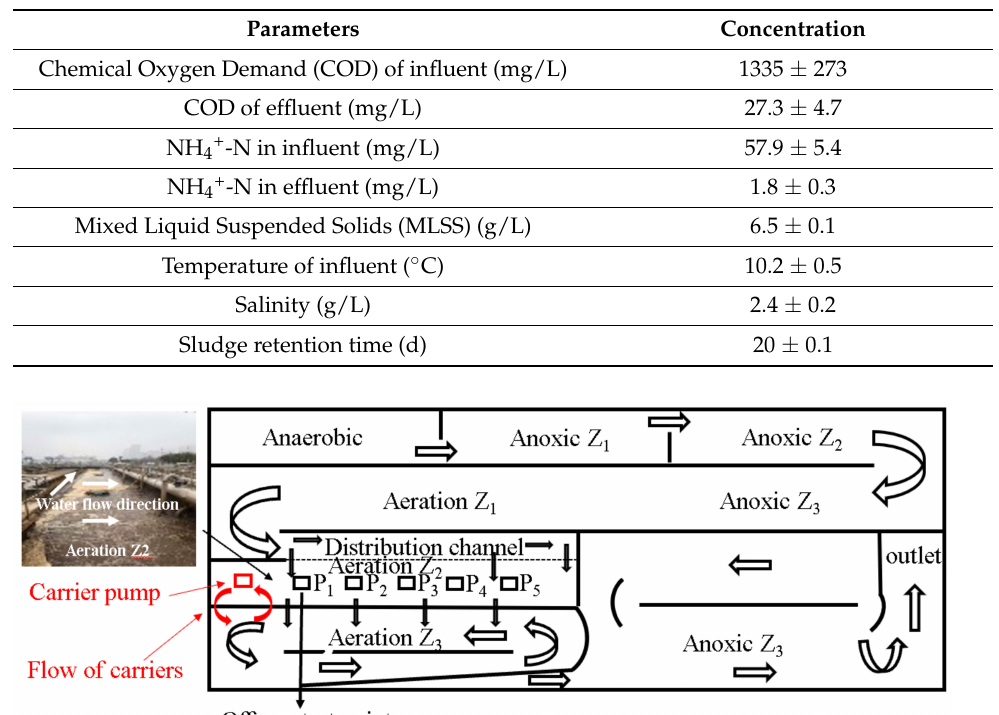
Table 1. Plant operating conditions during testing.